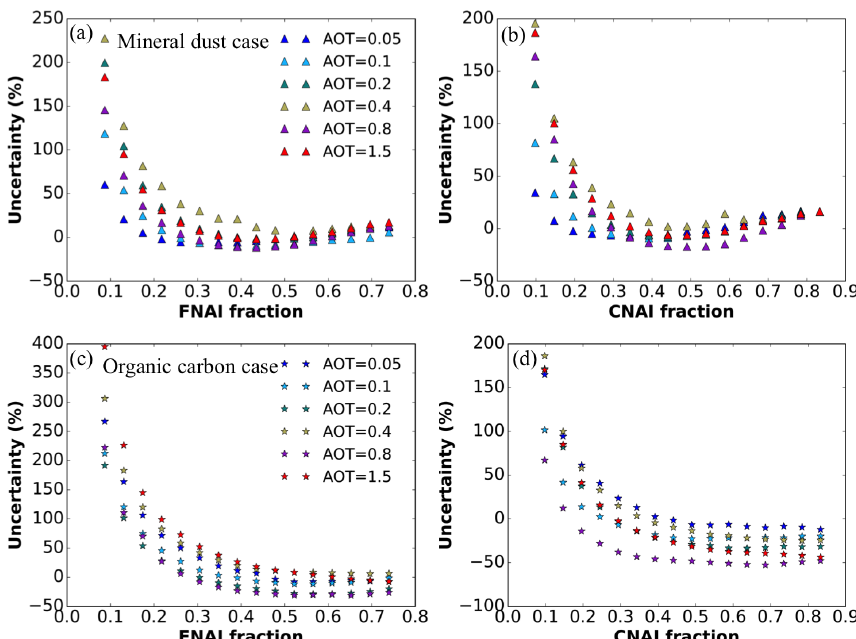
Figure 7. Uncertainty in the non-absorbing insoluble particles fraction in the fine (FNAI) and coarse (CNAI) modes attributed to the refractive index variability: (a, b) for mineral dust and (c, d) organic